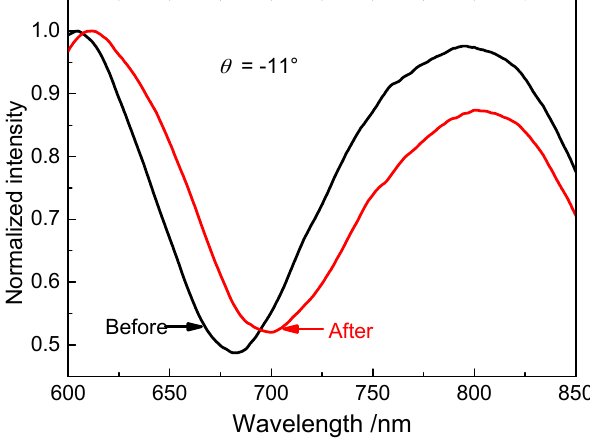
Figure 3. SPR spectra measured at θ = − 11° with the NPG film exposed to air before and after modification with 1-dodecanethiol.